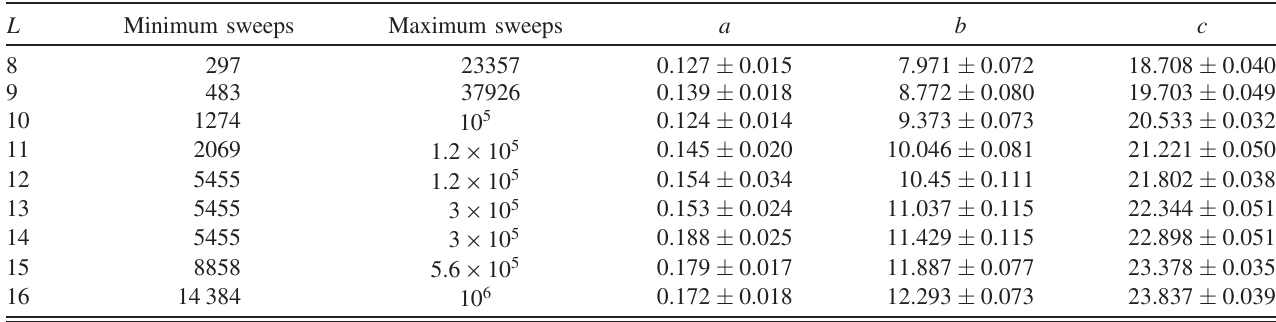
TABLE XII. Fit to y ¼ a ð x − b Þ 2 þ c for the median results of the hardware-planted instances using SAA with y ¼ log TTS and x ¼ log n . The factor c does not include f sweeps